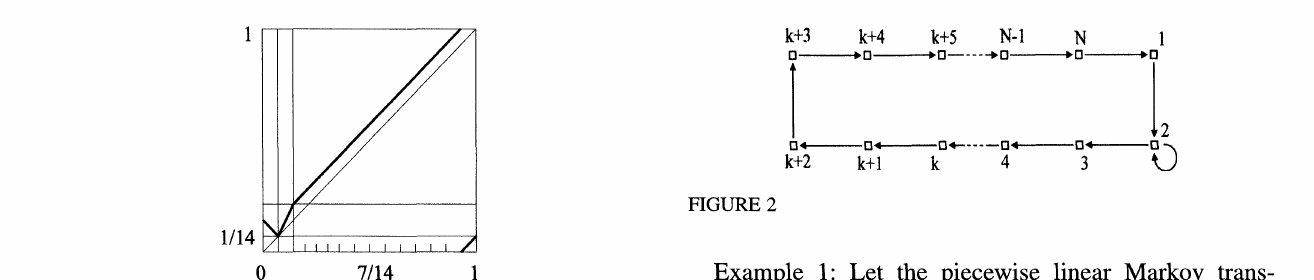
1/14 / 0 7/14 FIGURE an actual removal of a physical component of the system.